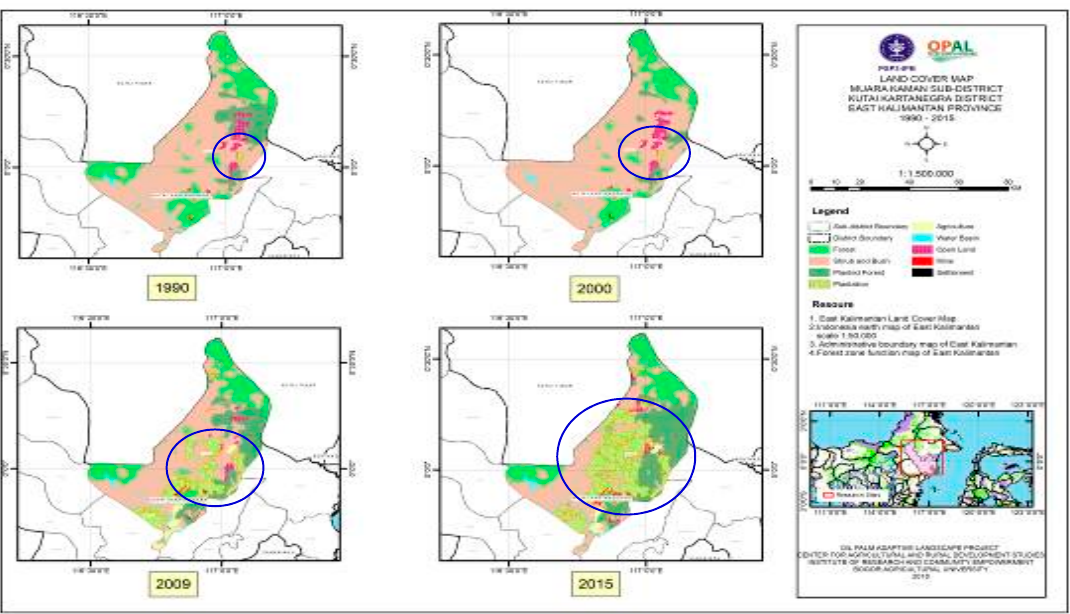
Figure 3. Land-cover changes in Muara Kaman sub-district between 1990 and 2015. Source: Secondary data, processed, 2018.